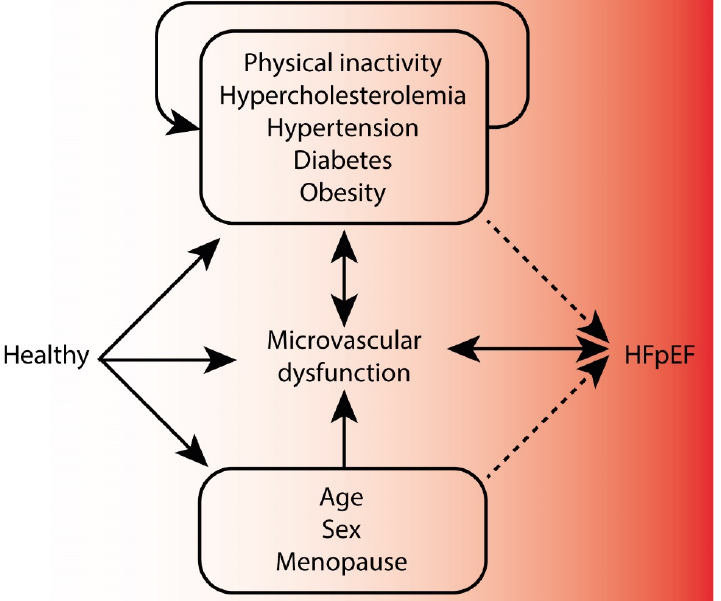
Figure 3. The potential causal web of clinical correlates for MVD and HFpEF. Clinical correlates affect both microvascular dysfunction (MVD) and heart failure with preserved ejection fraction (HFpEF), and in a bi-directional manner, creating a complex causal web. Yet, these clinical factors could also influence HFpEF development and progression through other mediating mechanisms (dotted lines) that are to be further elucidated. Moreover, the specificity of microvascular abnormalities for HFpEF requires further research. Causality of the clinical factors with systemic MVD and how this would drive HFpEF is still a knowledge gap.